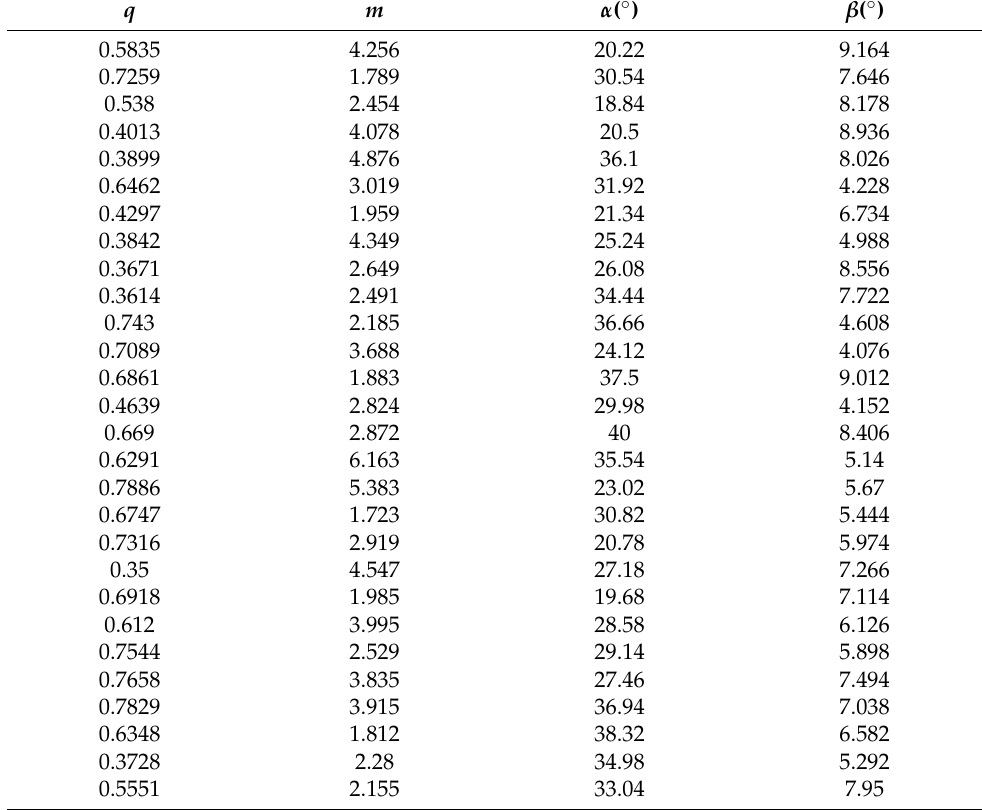
Table A1. Design parameters and efficiency of DOE sample